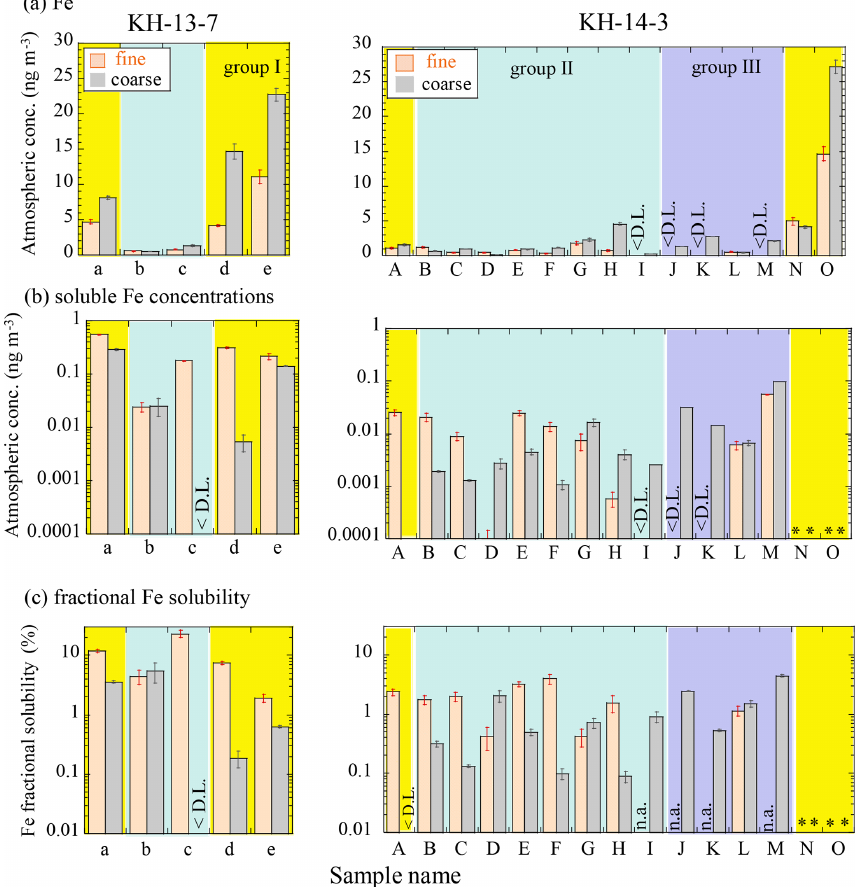
Figure 3. Atmospheric concentrations of (a) Fe and (b) soluble Fe, as well as the (c) fractional solubility of Fe of fine and coarse particles, during the KH-13-7 and KH-14-3 cruises. Errors were calculated from ICP-MS errors and blank subtraction errors. Yellow, blue, and purple areas indicate groups I (air masses from the direction of East Asia), II (air masses from the central and eastern Pacific), and III (air masses from the northern North Pacific), respectively. < D.L.: below the detection limit due to higher concentrations in the blanks than samples; n.a.: not available because the total Fe concentration was too low. ∗ Not analyzed due to insufficient sample